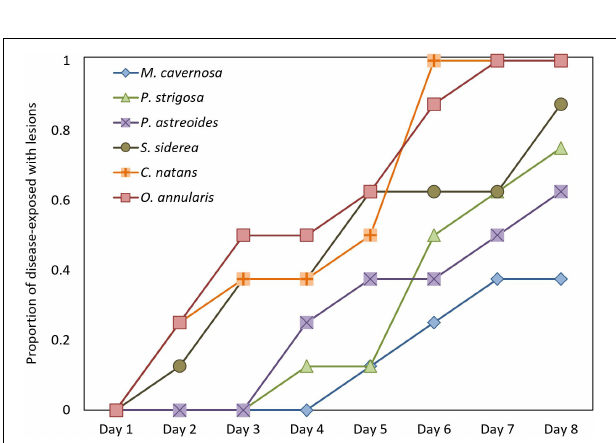
FIGURE 4 | Disease Incidence. Time to appearance of disease lesions consistent with stony coral tissue loss disease (SCTLD) on healthy fragments exposed to a SCTLD-affected colony of Diploria labyrinthiformis ( n = 8 per